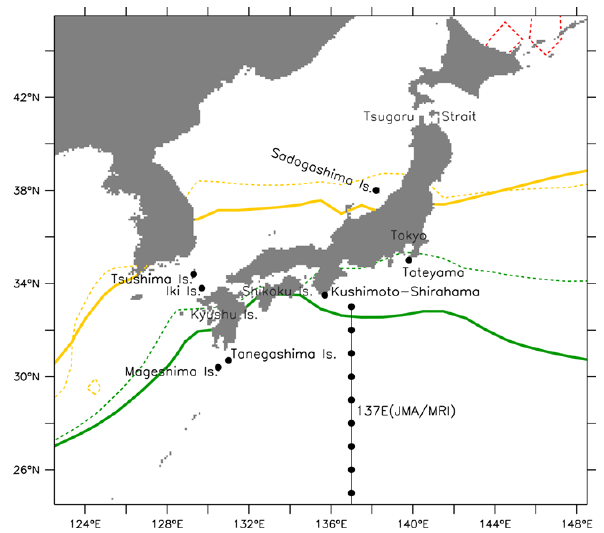
Fig. 1. Study site locations. At present, Sadogashima Island (138.2 ◦ E, 38.0 ◦ N) marks the northern limit of the temperate coral occurrence. Kushimoto-Shirahama (135.7 ◦ E, 33.5 ◦ N) and Tateyama (139.8 ◦ E, 35.0 ◦ N) are located in the current transition area of the tropical/subtropical coral community and the temper- ate coral community. The JMA/MRI cruise was a 137 ◦ E transect used to validate the projected SST and (cid:127) arag . Isothermal lines of SST=18 ◦ C (solid green line) and 10 ◦ C (solid yellow line) and iso- lines of (cid:127) arag = 3 . 0 (dotted green line), 2.3 (dotted yellow line) and 1.0 (red dotted line) during the coldest months are also